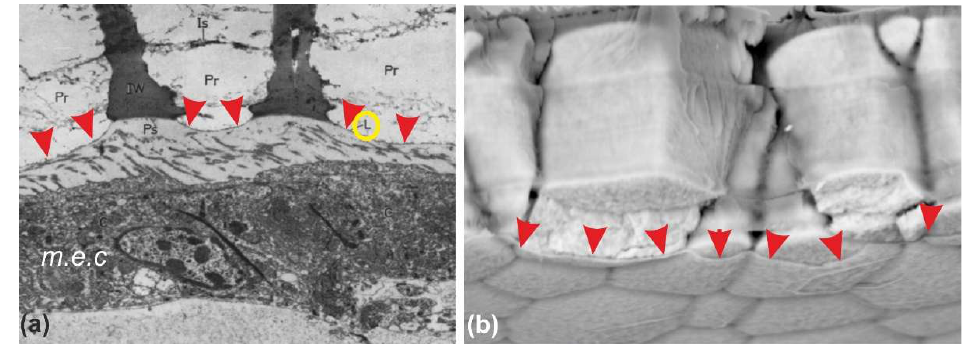
Figure A5. Models of fluid-filled extra-pallial chambers in which moving molecules go to the right places to build the shell layers. ( a ) Model from Saleuddin and Petit [36]. ( b ) Model from Saleuddin and Wilbur [37]. Credit pictures (a): [36]; (b): [37].